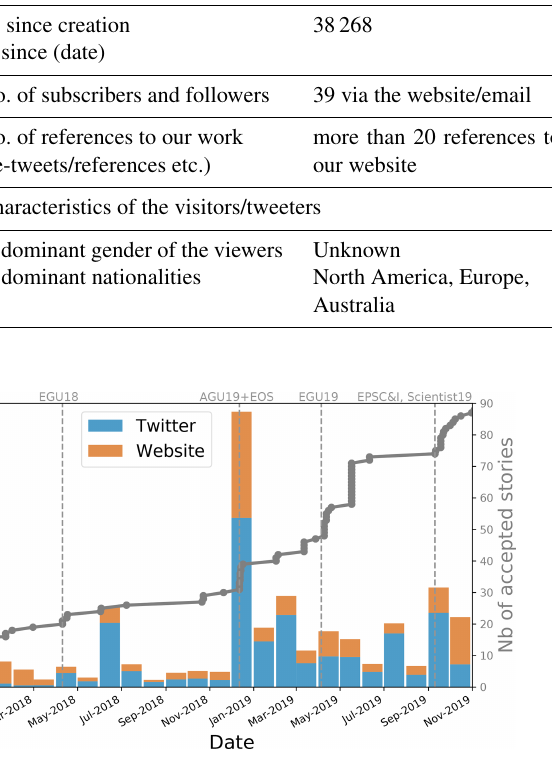
Figure 9. Evolution of the monthly number of views on Twit- ter and on the website https://didthisreallyhappen.net/ (last access: 9 March 2020, DTRH team, 2019a), and the number of accepted stories (as a function of their date of reception) since the website launch in January 2018. There is a correlation between the high number of views, presentations of the project at international con- ferences and peaks of reception of testimonies that we accepted. Also, note that the number of views increased significantly after De- cember 2018 as we are getting more attention in the past year. EGU stands for the European Geosciences Union General Assembly in Vienna, AGU for the American Geophysical Union Fall Meeting, and EPSC for the European Planetary Science